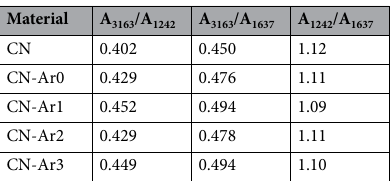
Table 3. Ratios of FTIR absorbances of CN and CN-Ar